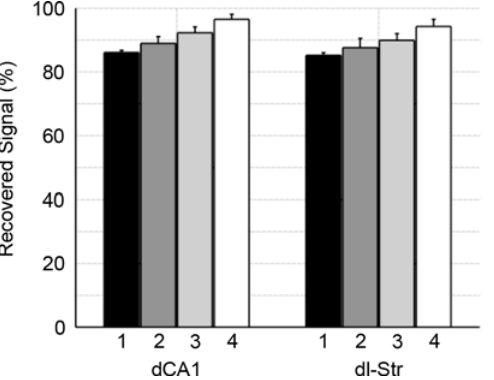
Fig 8. Recovered LFP following artefact removal. The mean percentage of recovered LFP + SEM is shown for both dCA1 and striatal (dl-Str) brain regions, for behavioural sessions 1 – 4. The percentage of recovered signal increased for both brain regions, from ~85% in session 1, to ~95% in session 4.